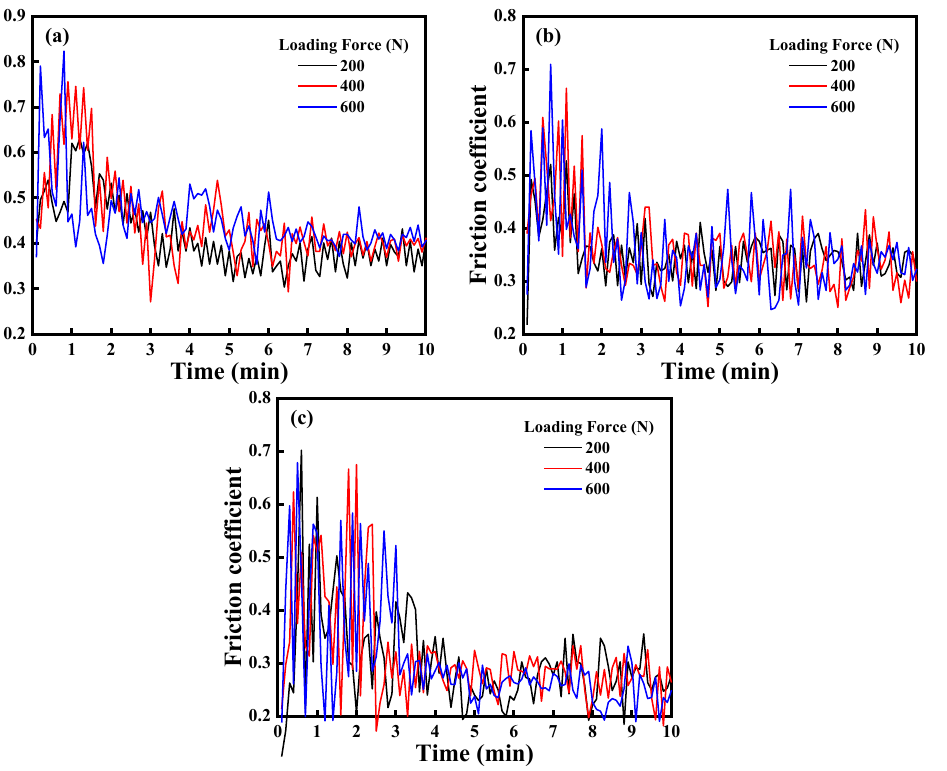
Figure 4. Variation friction coefficient with friction time of different coal samples under different loads: ( a ) JLS; ( b ) GHS; and ( c ) ZG.